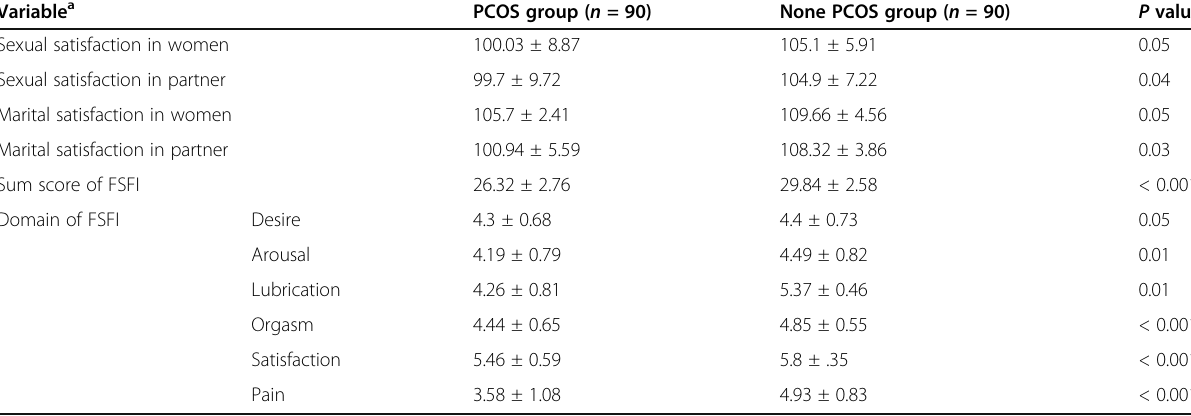
Table 2 Comparison of sum scores of sexual function and satisfaction between participants Variable